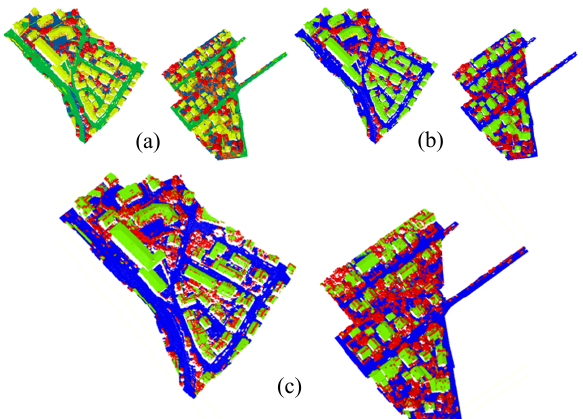
Figure 8. Evaluation data with: (a) original classes, (b) adjusted classes, (c) 2D CNN classification results for Vaihingen.